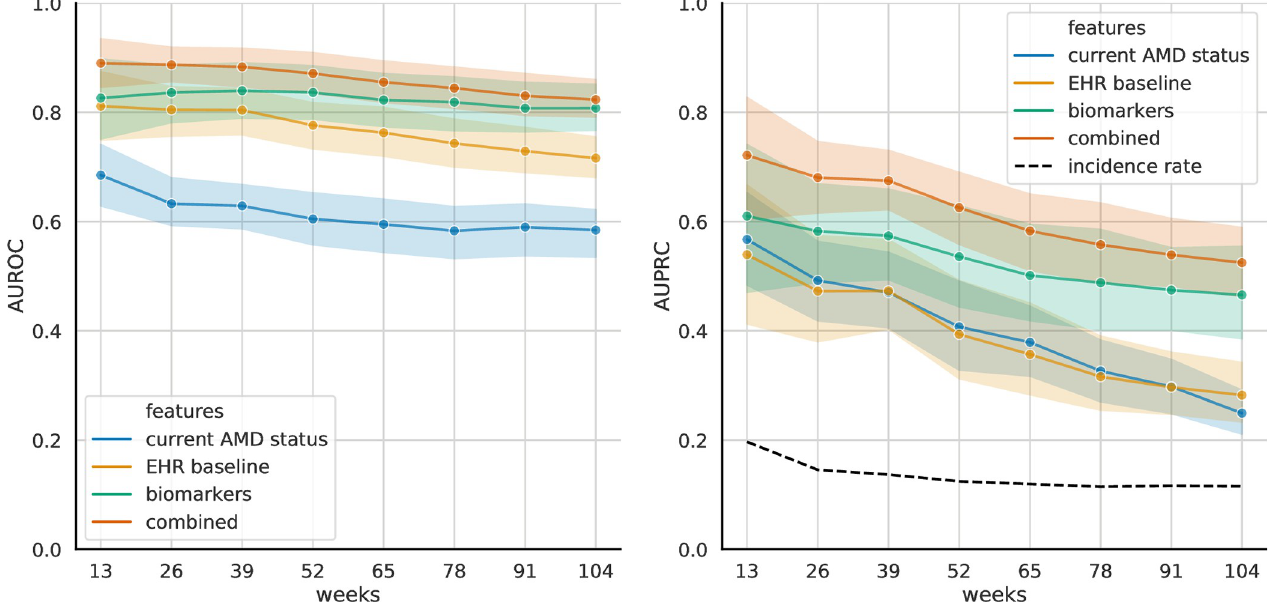
Fig 2. Prediction of exudative AMD Conversion by the 2-year model, evaluated at different time frames. L eft . Area under the ROC curve (AUROC) as a function of prediction time frame. Right . Area under the Precision-Recall curve (AUPRC) as a function of prediction time frame. 95% Confidence intervals were computed using bootstrapping.